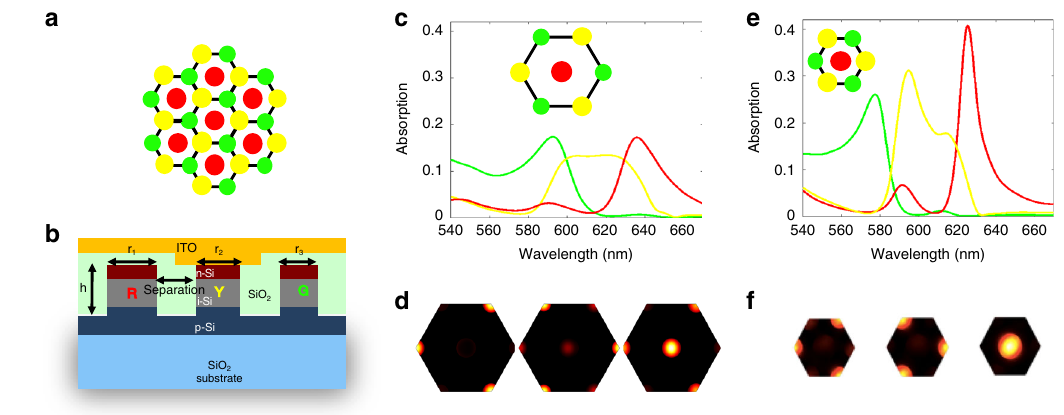
Fig. 1 Optical design and simulation of three-channel, two-dimensional, anti-Hermitian PIN Si metasurface. a Top- and b side-view schematic of 3-color, 2-D array of silicon nanocylinders. c , e Simulated absorption spectra of normally incident light in green-, yellow-, and red-absorbing nanocylinders for lattice constants of c 350 nm, mixed coupling condition, and e 220 nm, anti-Hermitian coupling condition. d , f Simulated dissipated power in each nanocylinder at the associated wavelength of peak absorption (590, 610, and 640 nm in d and 575, 590, and 625 nm in f ). It can be seen that when the lattice constant is above the anti-Hermitian regime, the three-color spectra are broad and overlapping, leading to optical color crosstalk between three- color channels. The optimal structure designed by the principle of anti-Hermitian coupling has enhanced quality factors, leading to a signi fi cant reduction of color crosstalk and improvement of the peak absorption ef fi ciency. Source data for c and e are available in the Source Data File tabs labeled 1c and e , respectively.